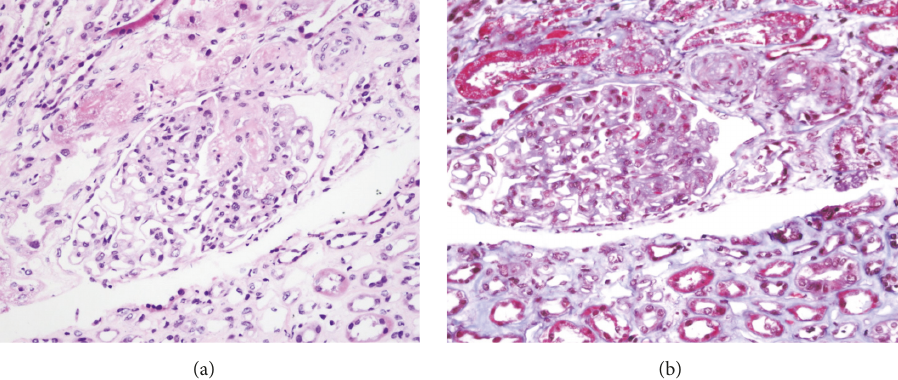
Figure 2: Glomerulus with subendothelialedema towards the vascularpole and arterioles with luminal obliterationdue to endothelialedema and fibrinoid necrosis. ((a) Hematoxylin and 40X eosin and (b) Trichrome